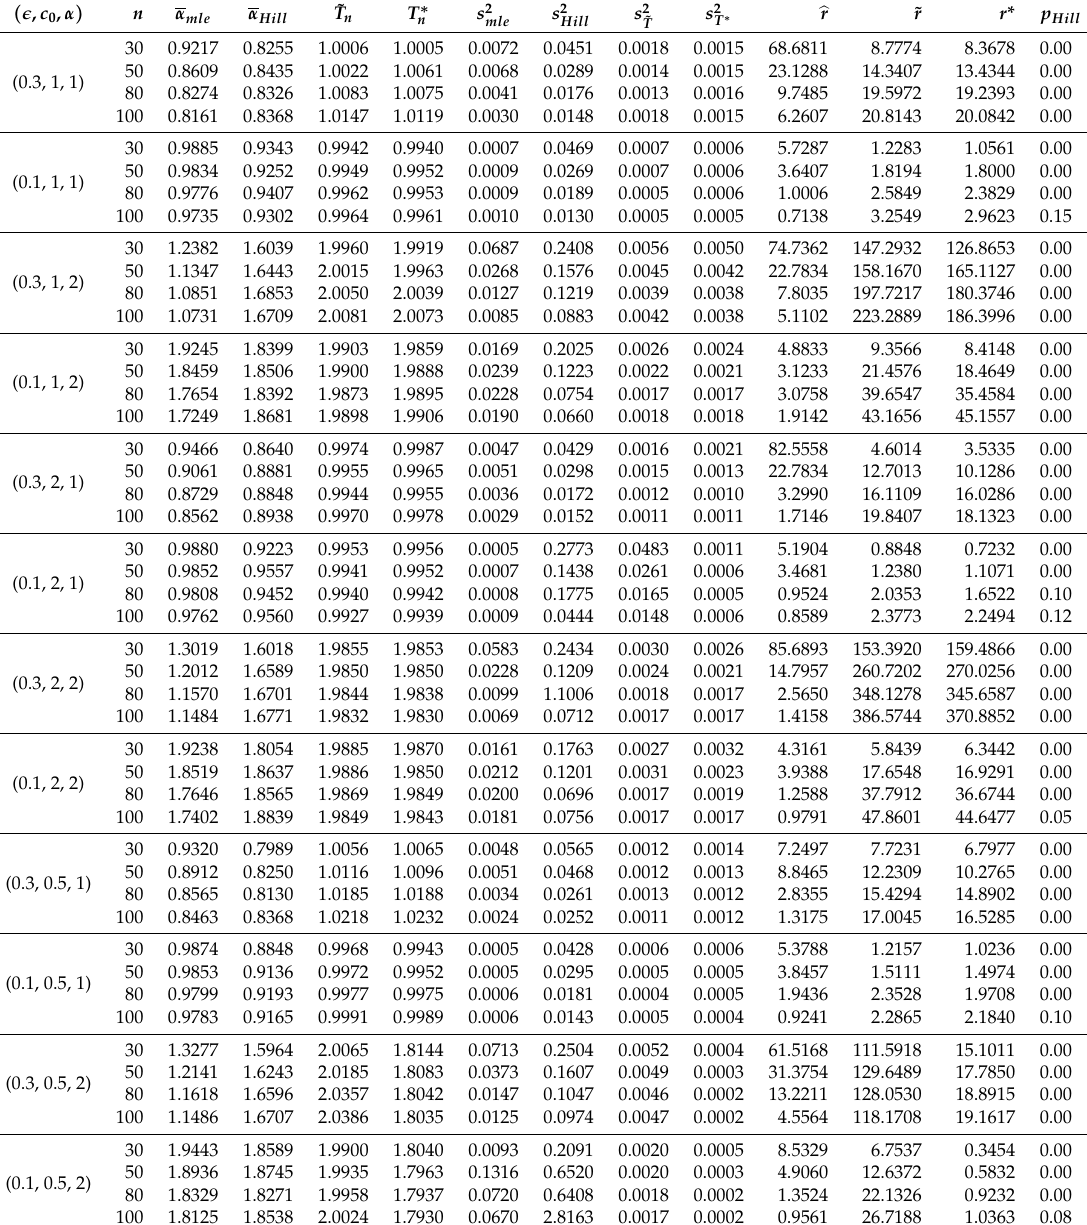
Table 1. Comparisons of ˜ T n , T ∗ n with (cid:98) α mle , (cid:98) α 100 from F (cid:101) ( x ) = ( 1 − (cid:101) ) F W ( x ; α ) + (cid:101) Γ ( x ;0.5,0.5 )